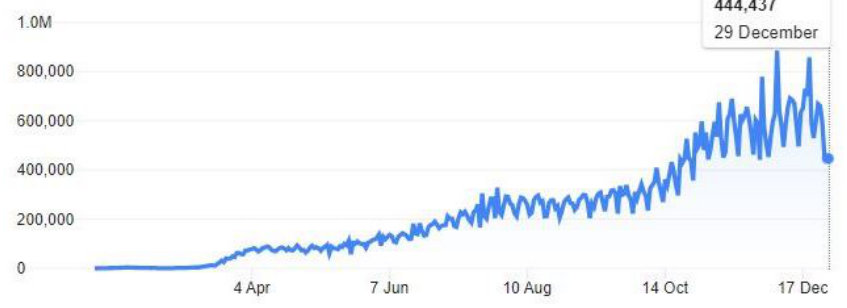
Figure 2. Worldwide daily COVID-19 reported cases [2].